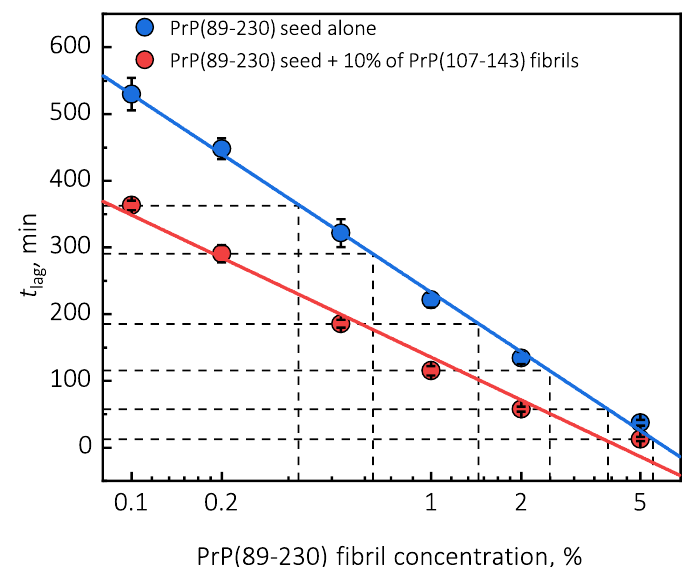
Figure A6. Comparison of t lag values of seed-induced aggregation reaction performed in the absence and presence of 10% of PrP(107-143) fibrils.